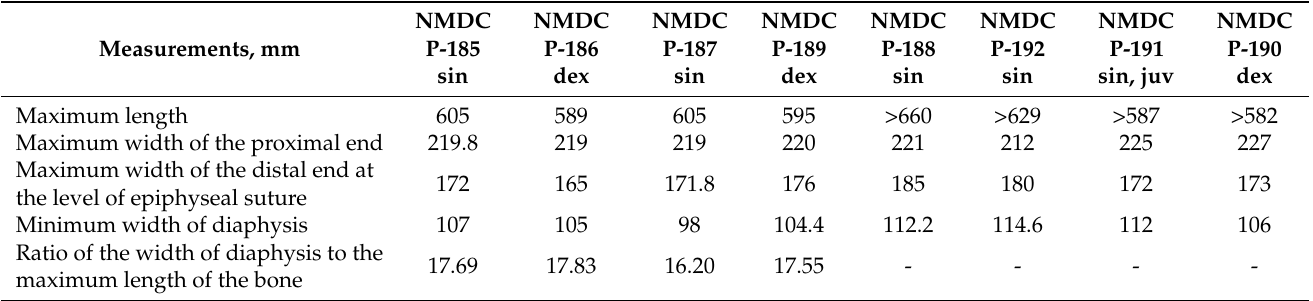
Table 5. Measurements of the tibiae of Mammuthus intermedius from Kamensk-Shakhtinskiy (the early Late Pleistocene; Rostov Region,